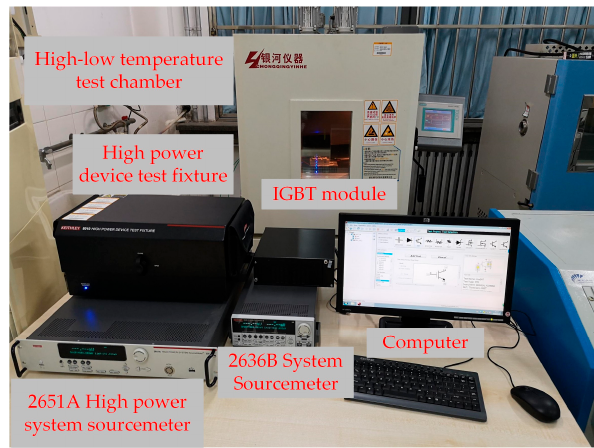
Figure 7. The semiconductor parameter test system.